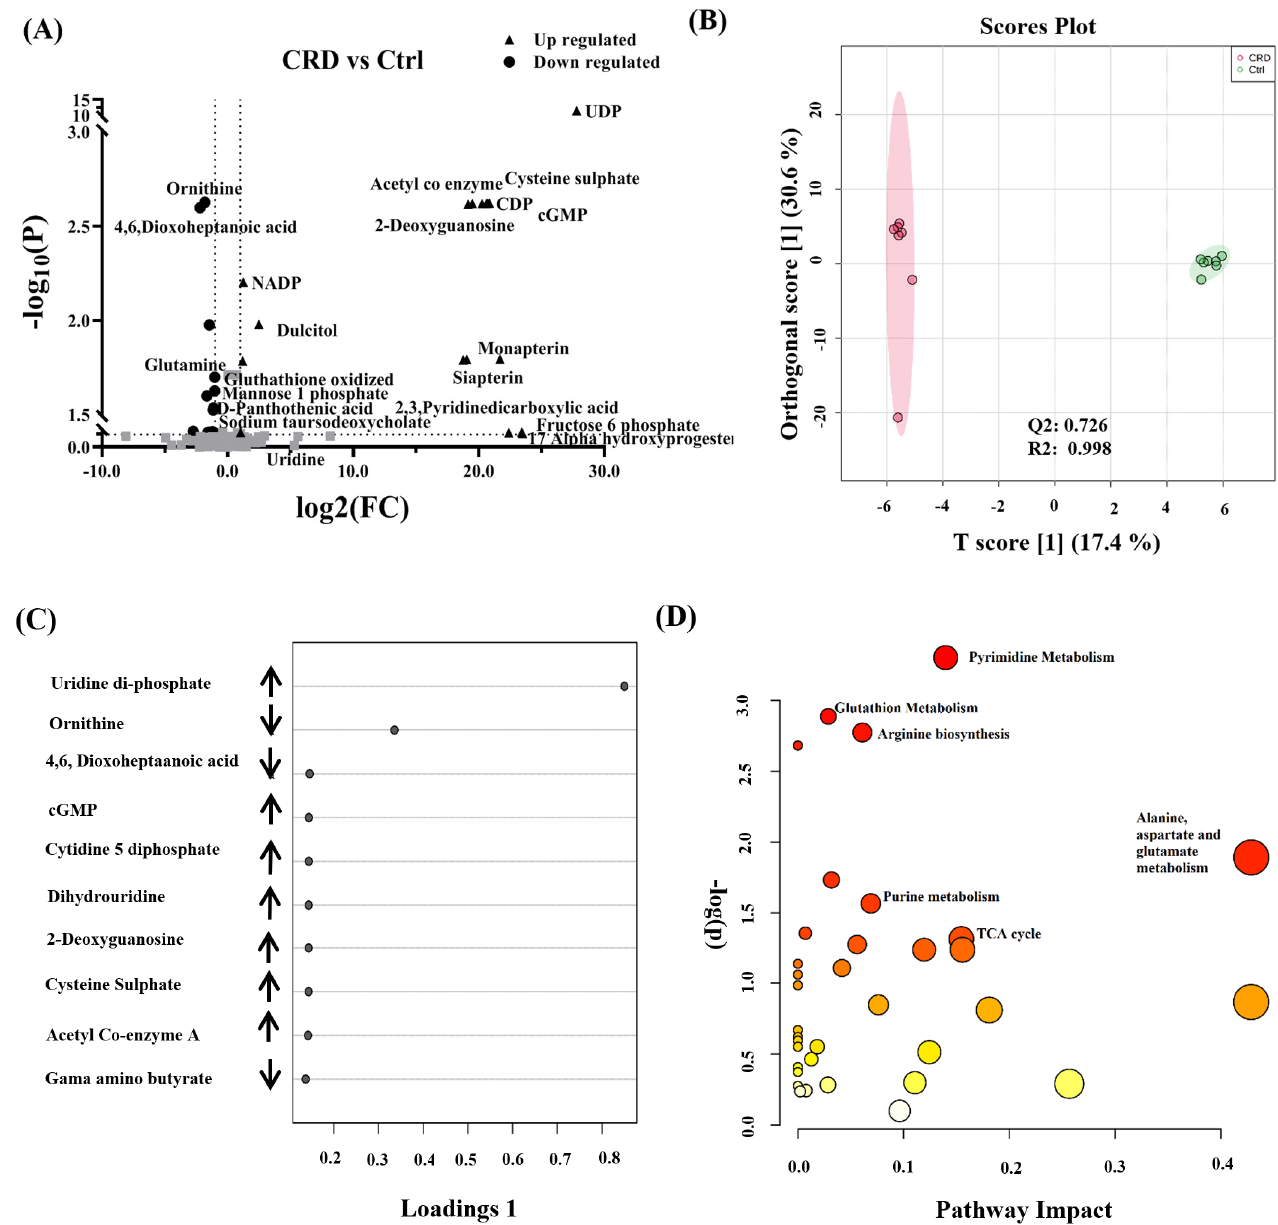
Figure 2. Binary comparison and pathway analysis in DBS of patients with cystic renal diseases (CRD). ( A ) Dysregulated metabolites between CRD vs. Ctrl with fold change cut-off 2 (up-regulated (n = 17) down-regulated (n = 15)) based on all detected features ( B ) Orthogonal partial least square discriminant analysis (OPLS-DA) score plot shows apparent clustering and separation, due to the biological differences between patients with CRD (n = 7) and healthy Ctrl (n = 7) (R2 = 0.998 and Q2 = 0.726) that represents the level of global metabolic differential expression (sample run in duplicates). ( C ) Loading plot shows the regulation of metabolic expression of metabolites in CRD compared to the Ctrl group. ( D ) Pathway analysis shows significantly altered amino acid metabolism and purine and pyrimidine, glutathione, and TCA cycle pathways. (color-coded and the circle’s size reflect the combination between the p -value and the pathway impact, respectively.).